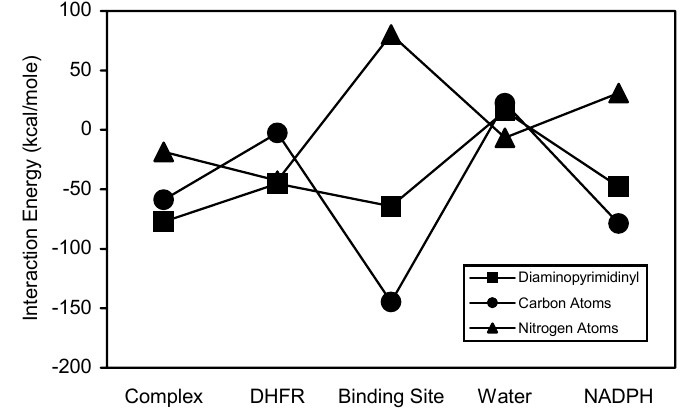
Figure 13. Comparison of interaction energy analysis of the diaminopyrimidinyl region of EPM with its carbon and nitrogen